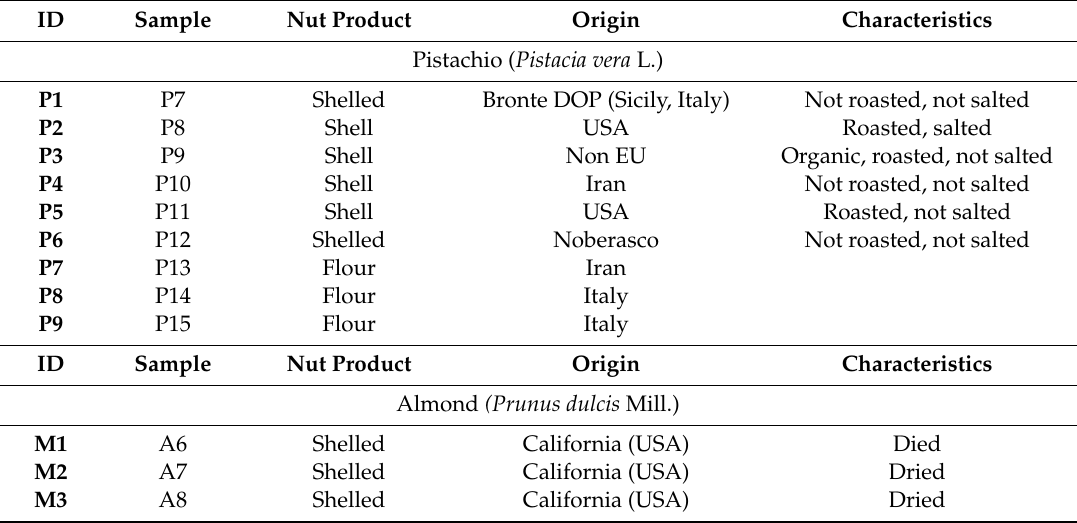
Table 3. Pistachio and almond samples examined in this study. The first column refers to the blinded analysis code and the second column to the sample